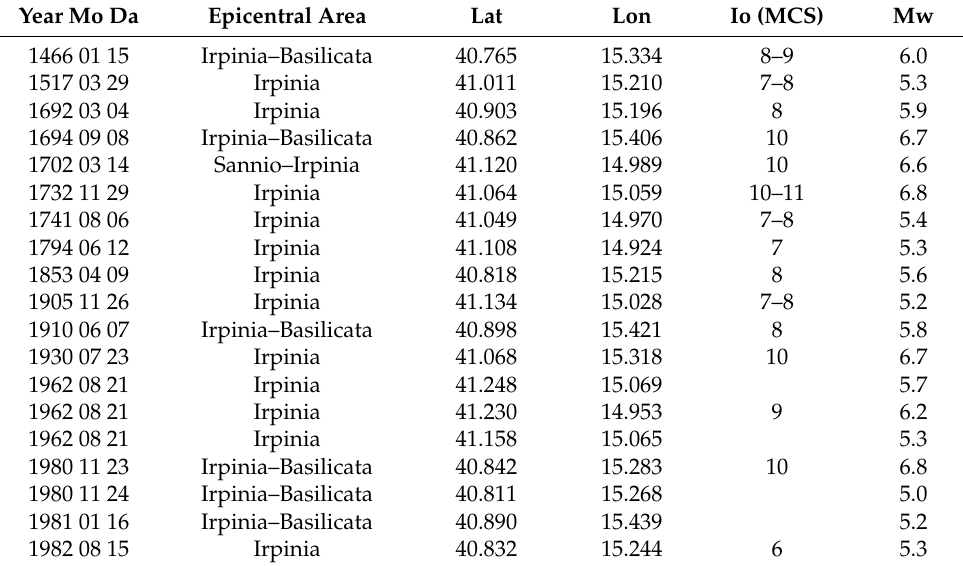
Table 1. List of the main Irpinia earthquakes (Mw > 5.0) extracted from the CPTI15 catalog [26]. For the description of the various parameters see this catalog at https://emidius.mi.ingv.it/CPTI15- DBMI15/index_en.htm (accessed on 30 January 2021) As attested by Rovida et al. [27], this historical record can be considered complete since 1620 for M 6.0+